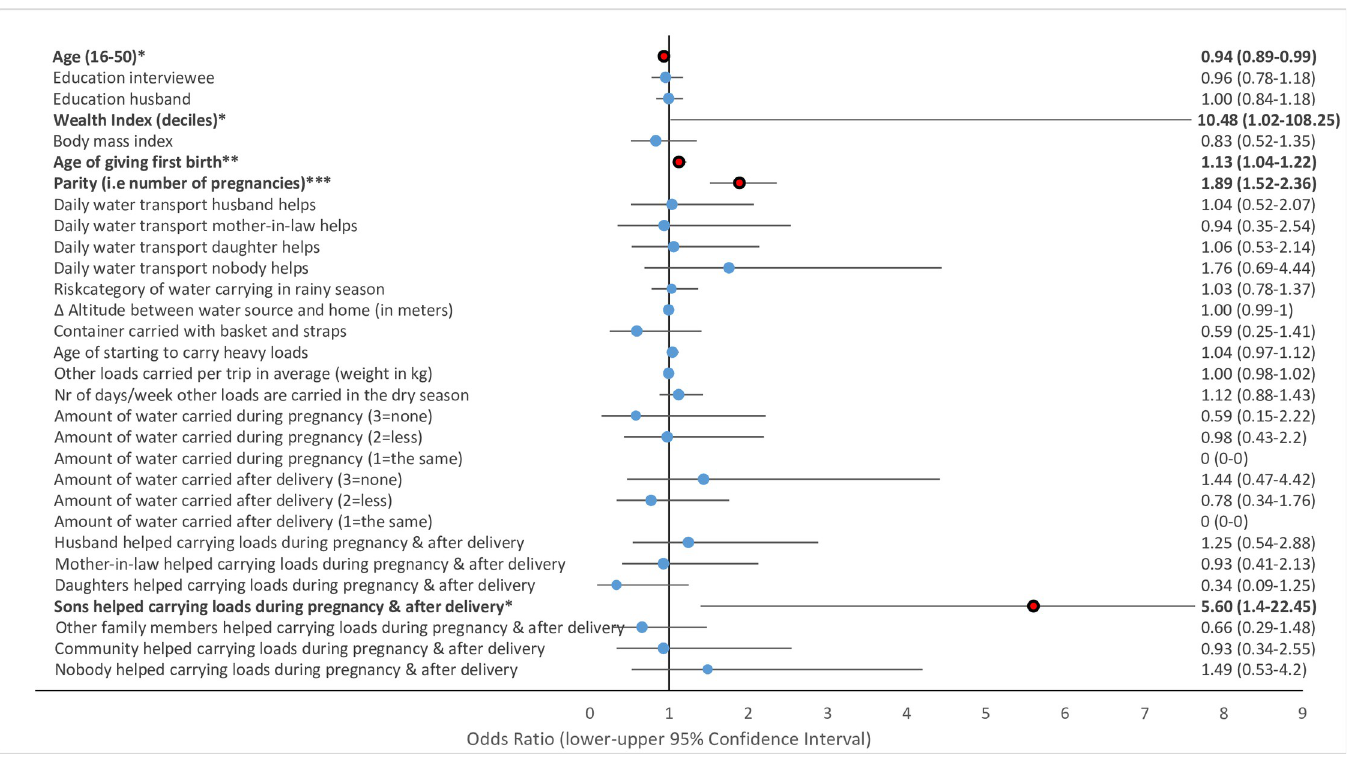
Fig 3. Association of risk factors with pain in the hips in multivariate GLMM. ( ��� = significant at the p < 0.001-level, �� = significant at the p = 0.01-level, � = significant at the p = 0.05-level; = odds ratio statistically non-significiant, ... = odds ratio statistically significant).